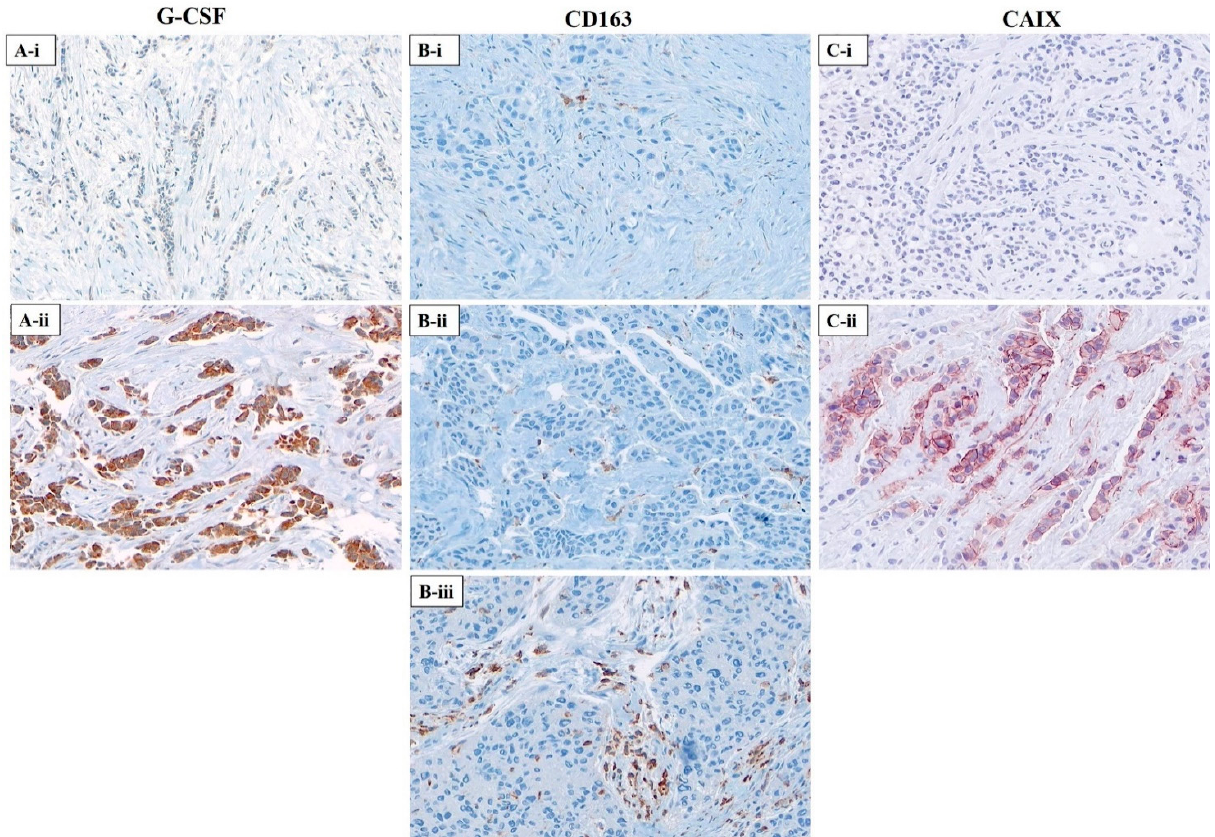
Figure 1. Representative photomicrographs for immunohistochemical staining of G-CSF, CD163, and carbonic anhydrase IX (CAIX) in breast carcinoma tissue microarray (cohort II) (Images acquired at 200X). ( A ) Cytoplasmic expression of G-CSF on breast carcinoma cells; ( A-i ) low ( ≤ 1); ( A-ii ) high (>1); ( B ) Membranous or cytoplasmic expression of CD163 on tumour- associated macrophages; ( B-i ) sparse infiltrates, ≤ 5 stained macrophages; ( B-ii ) moderate infiltrates, >5 but ≤ 25 positively stained macrophages; ( B-iii ) dense infiltrates, >25 positively stained macrophages; ( C ) Membranous expression of CAIX on breast carcinoma cells; ( C-i ) negative; ( C-ii )